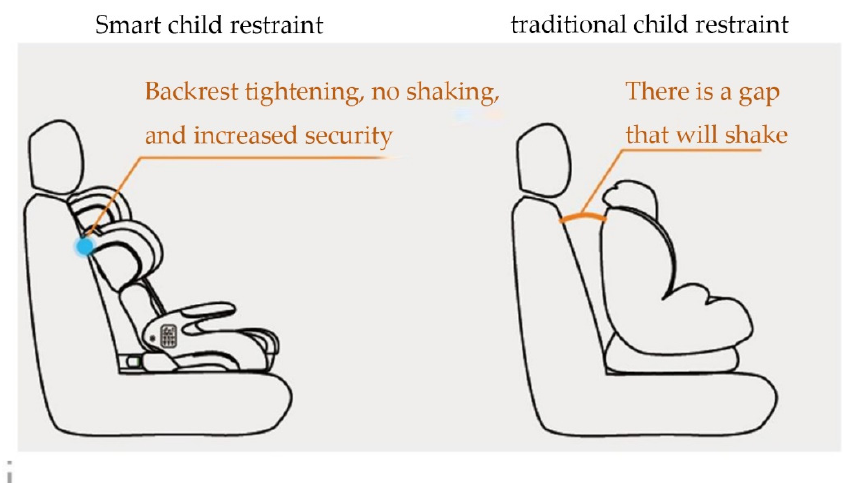
Figure 5. Comparison of intelligent safety seat backrest and traditional safety seat.